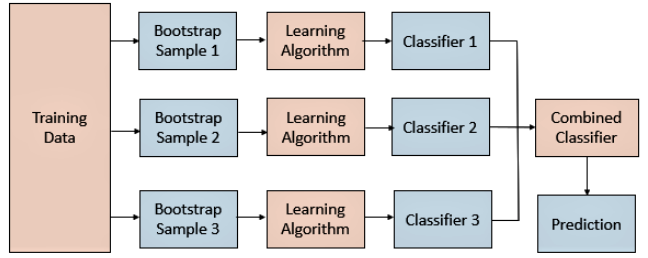
Figure 4. Ensemble learning (bagging) [25].